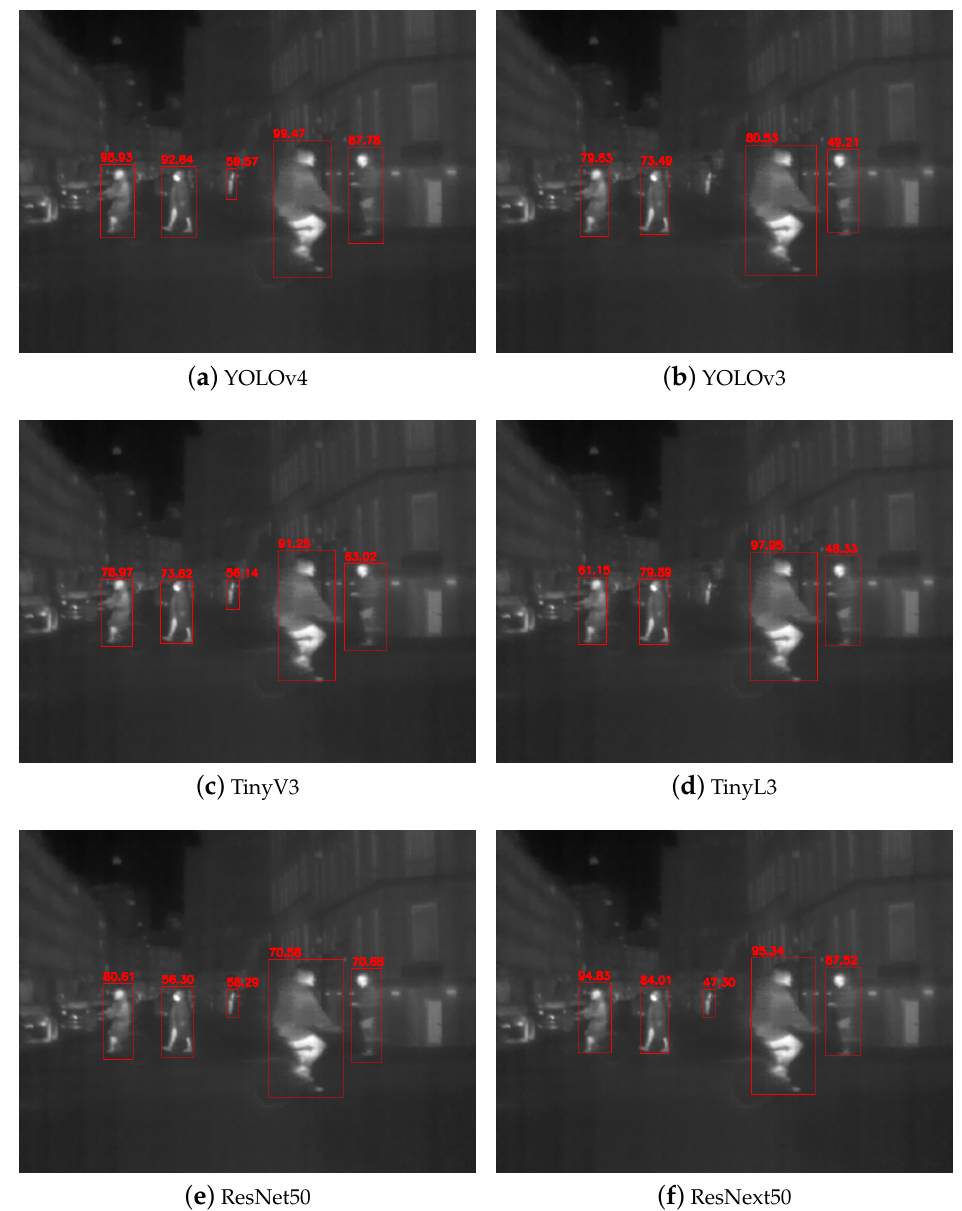
Figure 8. Comparison of detector performance after augmentation. Frame taken from ZUT dataset during the rain.